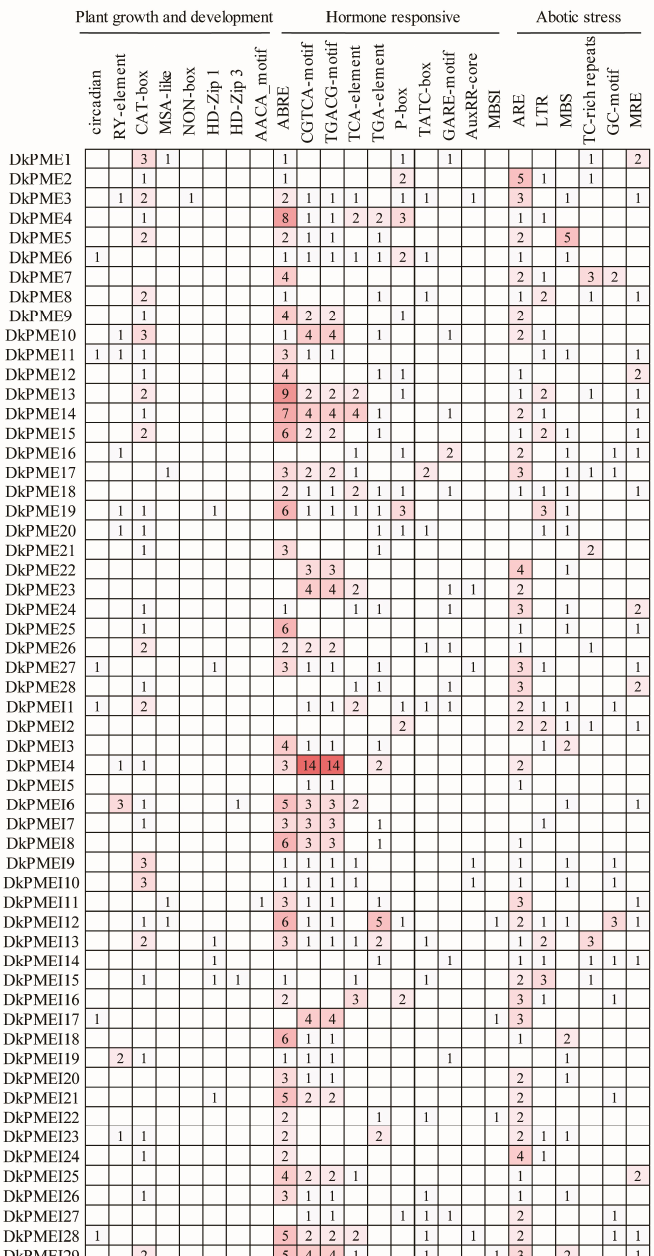
Figure 7. Cis-acting element in the promoter region of DkPME and DkPMEI genes.